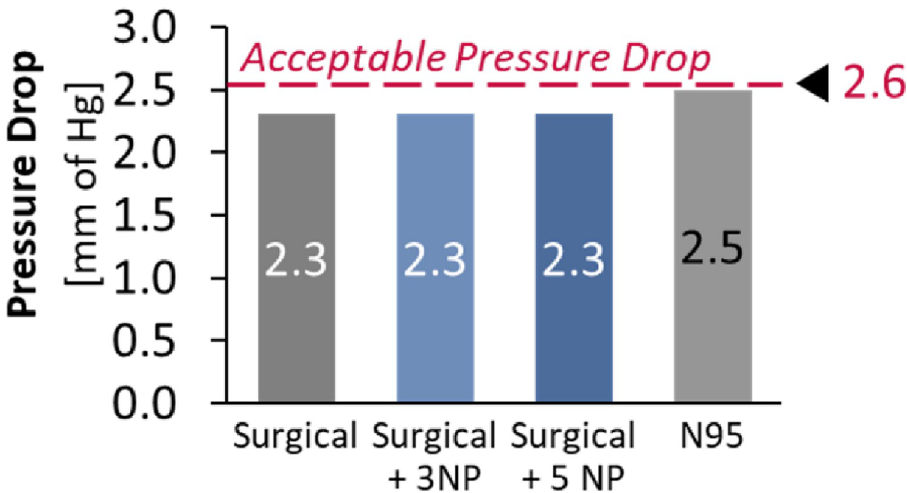
Fig 11. Pressure drop measurements on masks showed no significant change with addition of